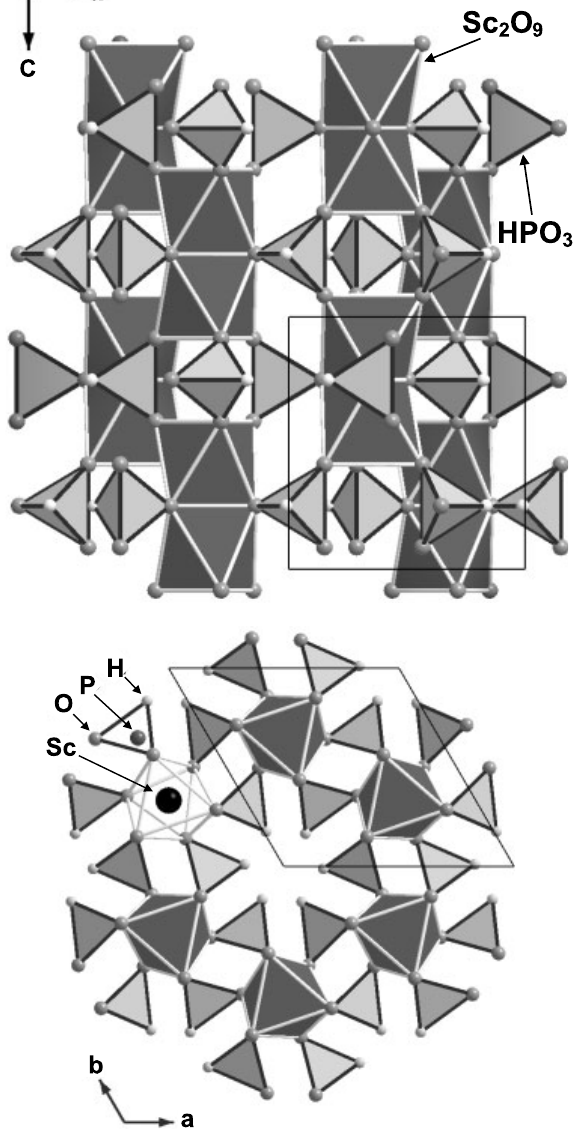
H 3 O 9 P 3 Sc 2 , hexagonal, P 6 3 / m (No. 176), a = 8.3055(7) Å, c = 7.697(1) Å, V = 459.8 Å 3 , Z = 2, R gt (F) = 0.028, wR ref (F 2 ) = 0.061, T = 293 K.